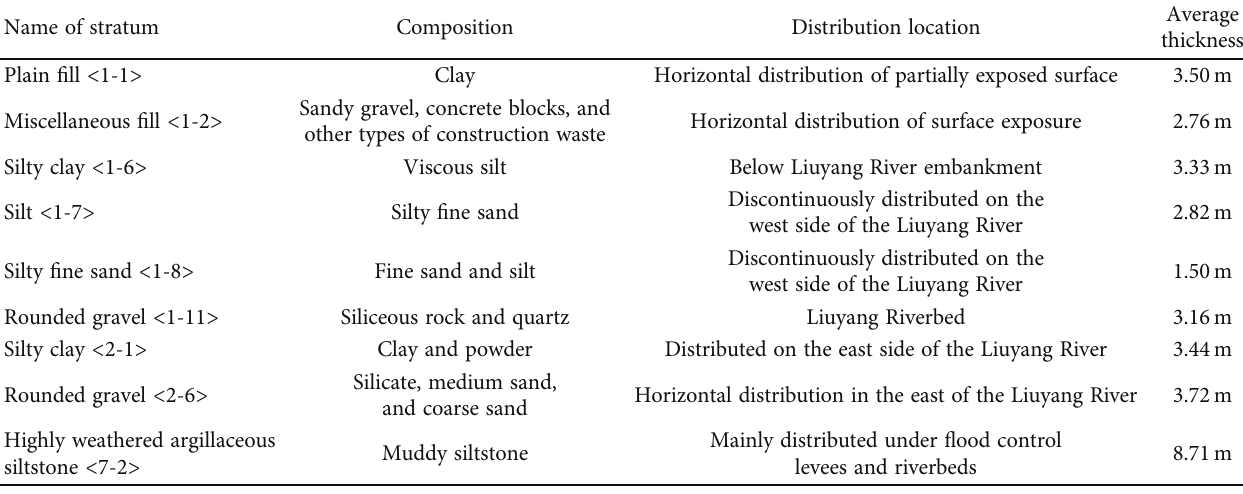
Table 1: Properties of the stratum.